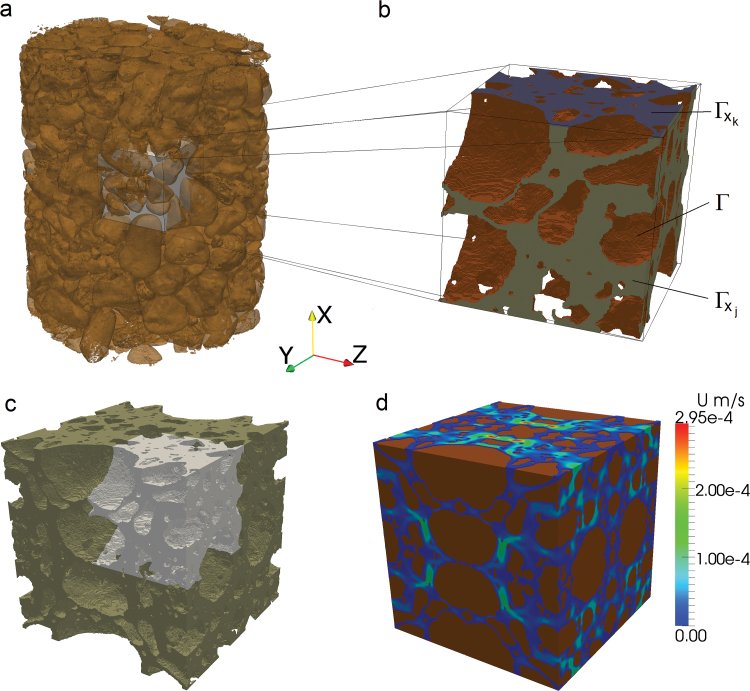
Schematic showing (a) subsampling of segmented volume, (b) subsampled geometry with boundaries Γx
k, Γx
j, and Γ for k=1, (c) the resulting truly periodic geometry created by reflection of the subsampled region in the x-, y-, and z-axis, and (d) a typical solution to the cell problem showing the absolute velocity. (This figure is available in colour at JXB online.)